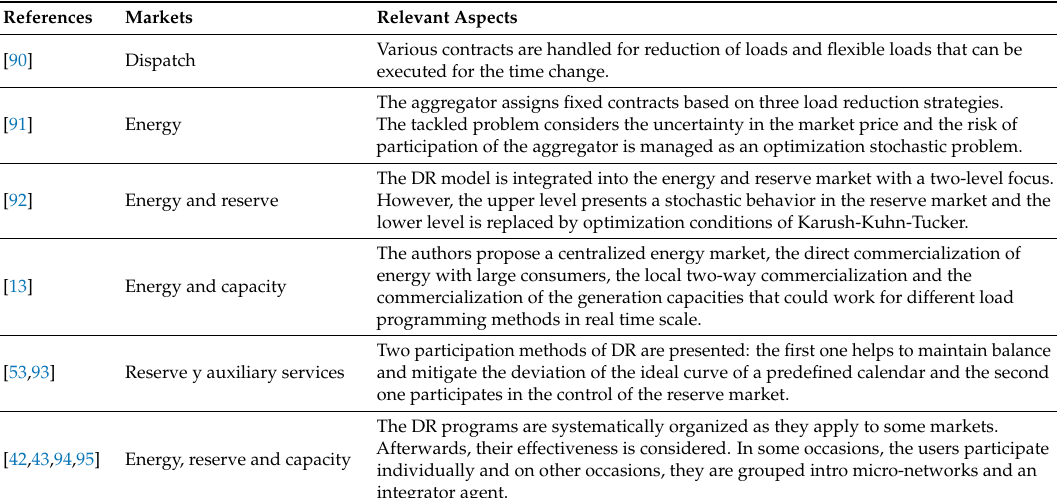
Table 4. Energy markets for